Question: How would you classify this visualization?
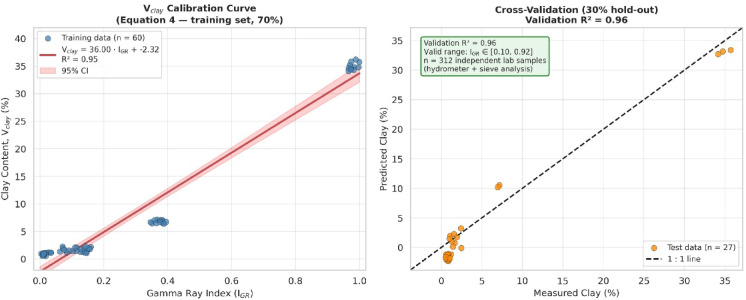
Answer: line